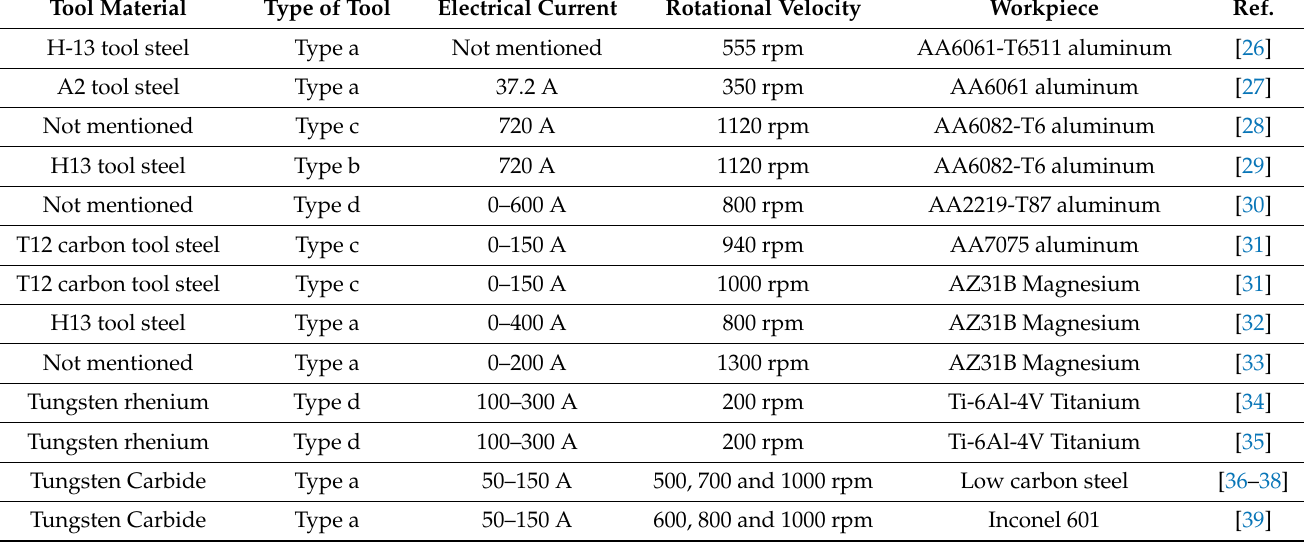
Table 1. Used tools and process parameters in EA-FSW of similar joints.